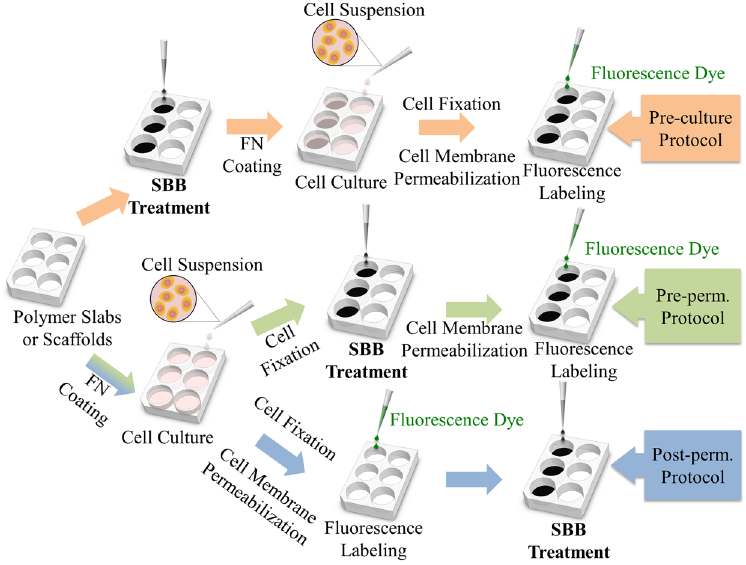
Figure 1. Three SBB treatment schemes. In pre-culture SBB treatment, the scaffold is treated with SBB prior to cell culturing. In pre-permeabilization (pre-perm.) SBB treatment, the scaffold is treated right after cell fixation, and followed by cell membrane permeabilization and the remaining steps of fluorescence labeling. In post- permeabilization (post-perm.) approach, the scaffold is treated after fluorescence